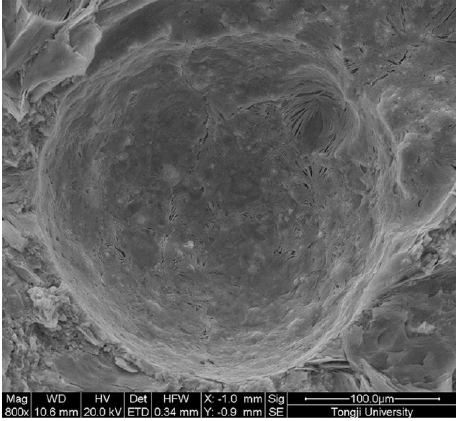
Figure 7. SEM observation of microcapsules morphology.